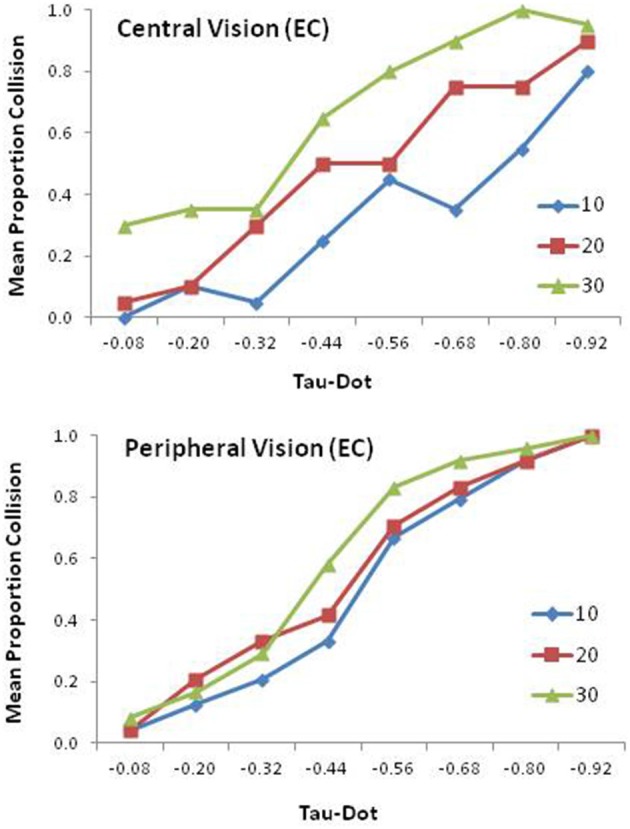
Mean proportion of collision responses for elderly controls as a function of tau-dot and mask size in the central (top panel) and peripheral (bottom panel) vision conditions.